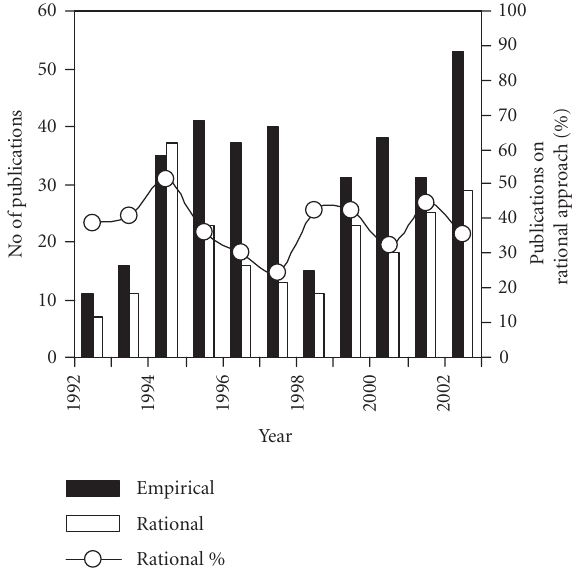
Figure 2. Number of publications on empirical approaches and rational studies of plant cell/tissue cultures, and the percentage of rational studies from 1992 to 2002. The search is based on the Biological